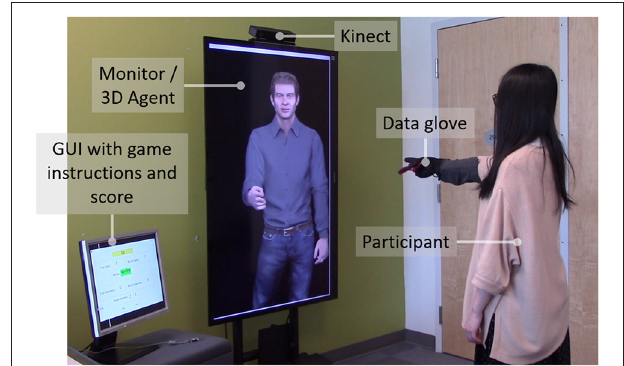
user. Five categories, corresponding to the combination of the extremes of the two dimensions of Extraversion and emotional stability plus a centre point were tested: High Extraversion/Low Stability (HELS), High Extraversion/High Stability (HEHS), Low Extraversion/Low Stability (LELS), Low Extraversion/High Stability (LEHS), Mid Extraversion/Medium Stability (Neutral).